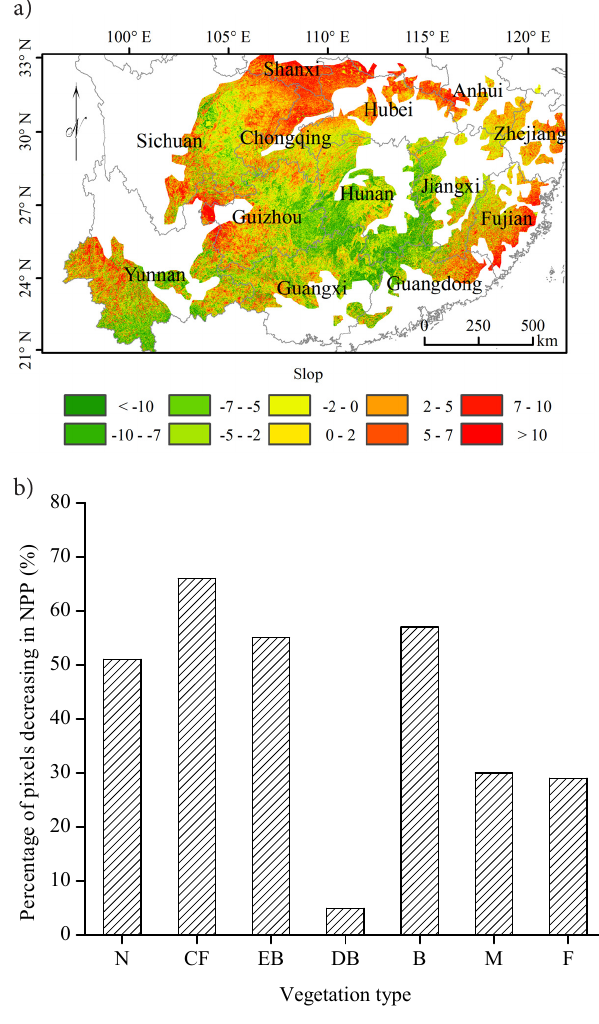
Figure 7. Temporal pattern of NPP in the study region. (a) pixel- based NPP temporal change trend from 2000–2010; (b) the per- centage of areas showing a decrease in NPP for each vegetation type. Abbreviations: N, coniferous forest; CF, Chinese fir; EB, ev- ergreen broad-leaved forest; DB, deciduous broad-leaved forest; B, brush; F, farmland; M,